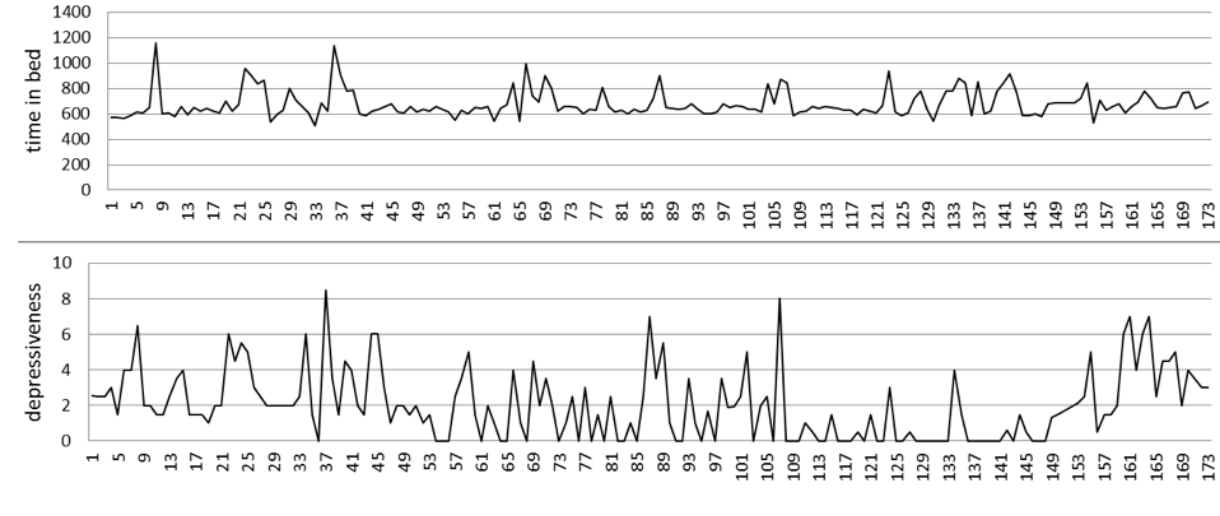
Figure 1. Raw time-series data of patient 2.